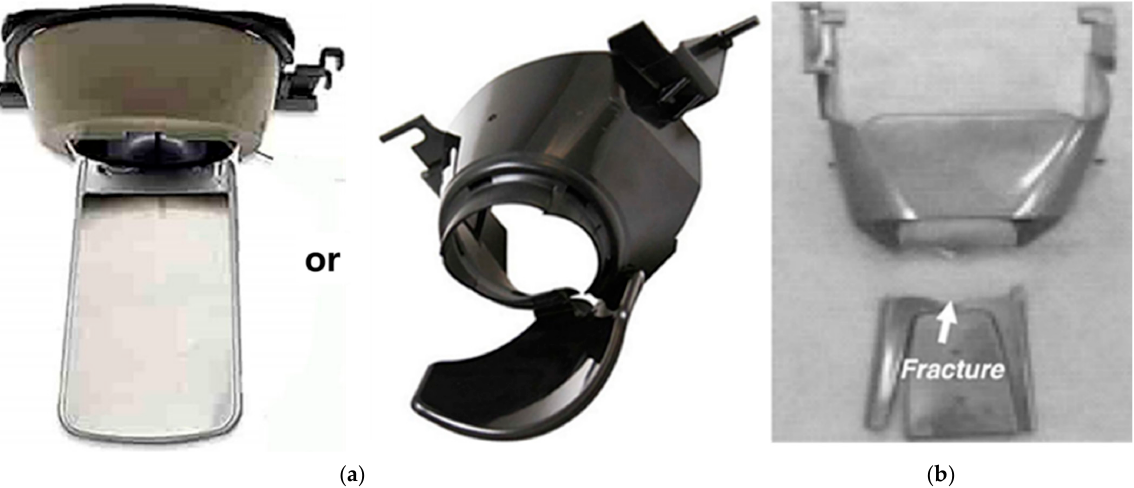
Figure 8. Damaged dispenser lever after usage. ( a ) Water dispenser and ( b ) failed dispenser lever in the field.